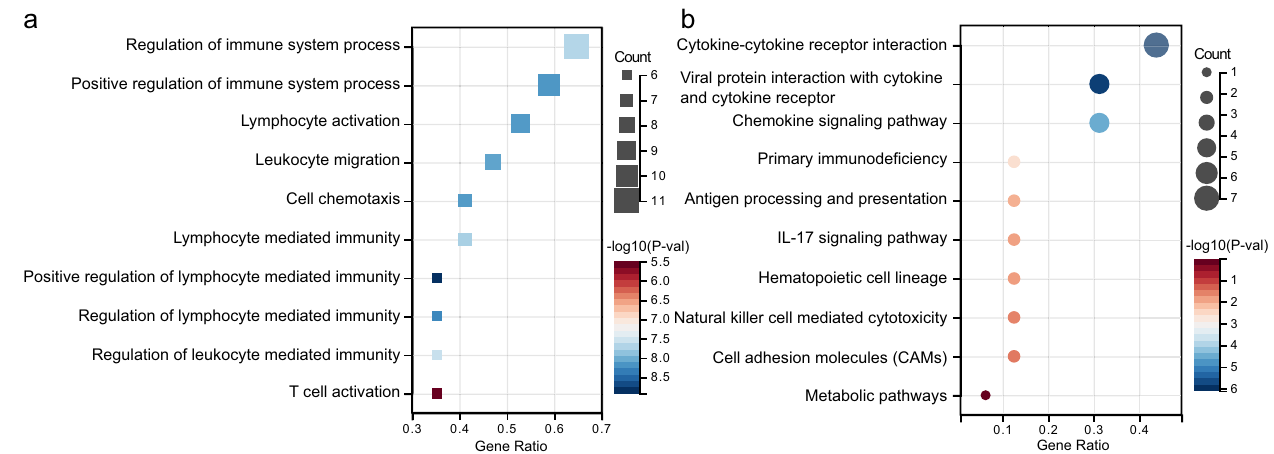
Fig. 4 The enrichment analysis of differential expression genes identi fi ed by comparing TCGA-LUAD with GTEx samples. a GO enrichment analysis. b KEGG enrichment analysis.